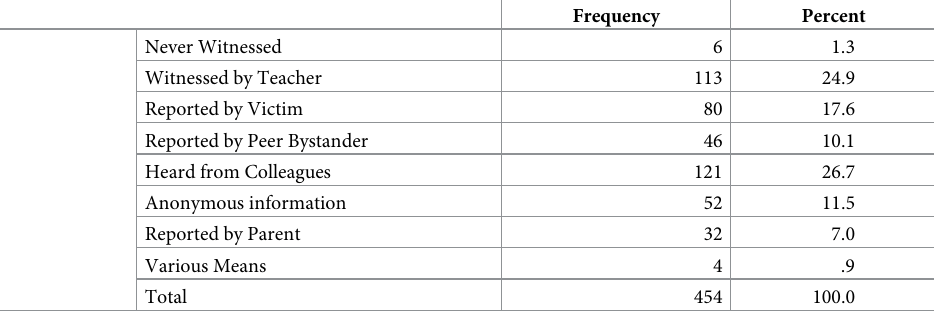
Table 4. Source from which teachers get information about bullying